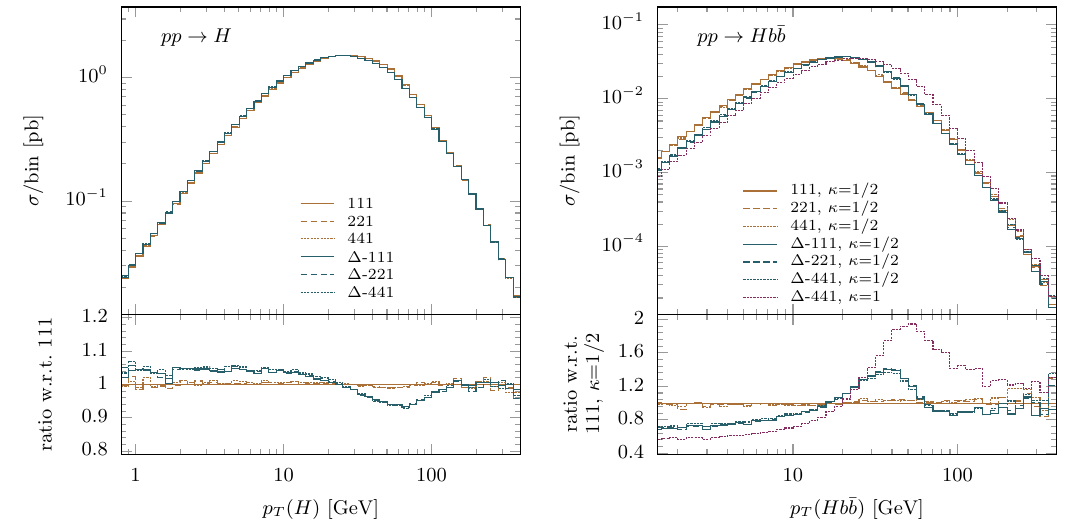
Figure 3 . As in (cid:12)gure 2, for the transverse momentum of the Higgs (left panel) and of the Hb (cid:22) b system (right panel), for the processes in eqs. (5.9) and (5.10), respectively. The latter displays an additional MC@NLO-(cid:1) curve (red dotted); see the text for details, in particular eq. (5.14) for the de(cid:12)nition of the parameter (cid:20)